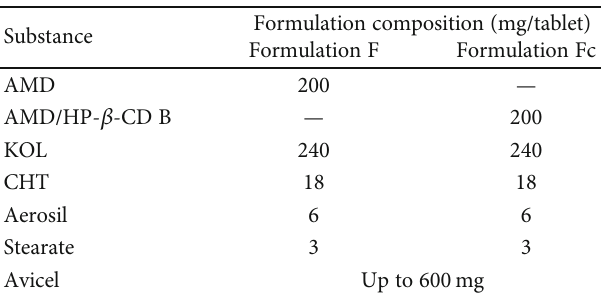
Table 2: Matrix tablet formulations containing AMD and/or HP- β - CD/AMD B complex and auxiliary